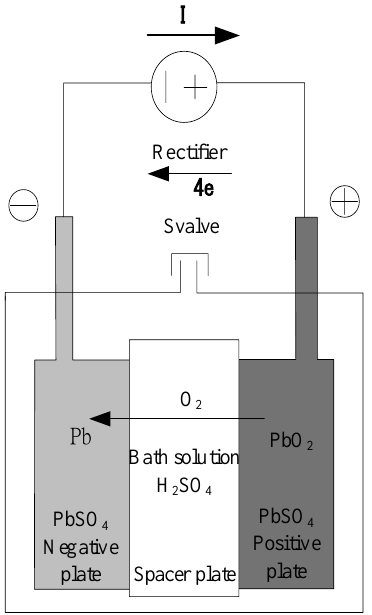
Figure 3. Schematic diagram of a lead–acid battery.